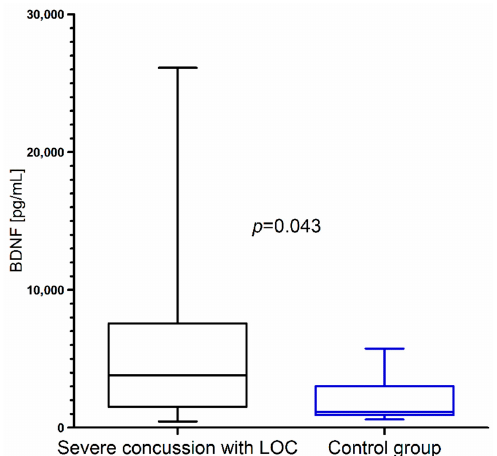
Figure 4. BDNF concentration in children with severe concussion with loss of consciousness (LOC) resulting from mild head trauma compared to the control group. resulting from mild head trauma compared to the control Comparing BDNF concentration between children with mild and severe concussion, we found that BDNF concentration was higher after severe concussion with LOC, but the difference between groups was not statistically significant. Furthermore, IL-8 concentration did not differ between both subgroups of children with mild head trauma (Table 2). ( p > 0.05). Table 2. BDNF and IL-8 concentration in children with mild head trauma: mild concussion without LOC vs. severe concussion with LOC. IL-8 [pg/mL]